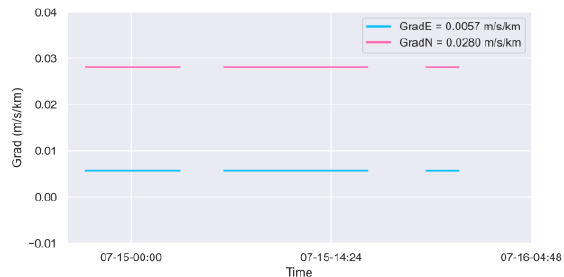
Figure 12 . 2D spatial gradient with